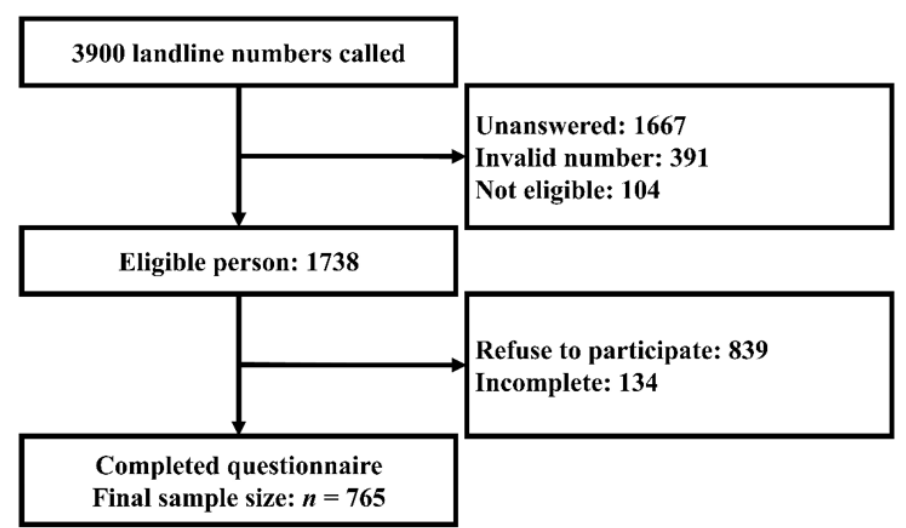
Figure 2. The algorithm of the final data collection.